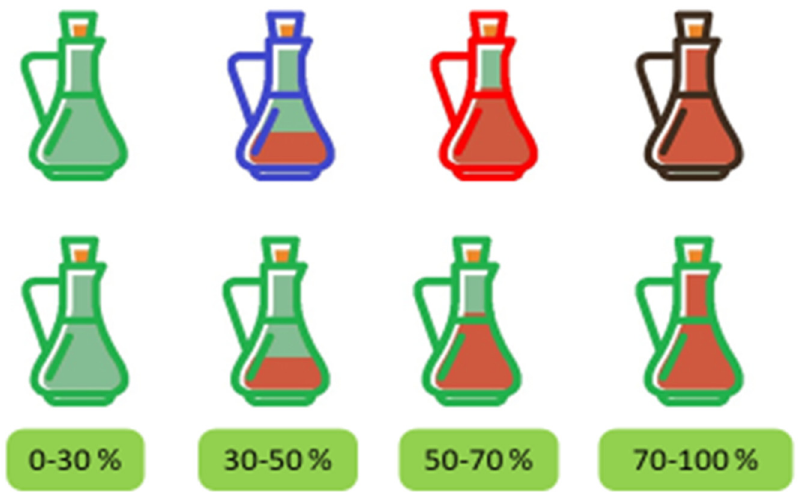
Figure 7. Different colors and fill possibilities of the graphic representation of the vinegar bottle resulting from the analysis.